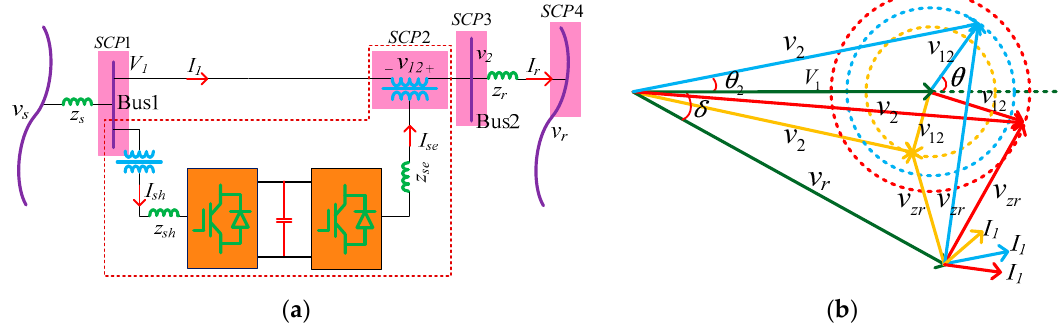
Figure 1. The structure and phasor diagrams of the unified power flow controller (UPFC): ( a ) Schematic diagram of the UPFC embedded system; ( b ) Phasor diagram of the UPFC embedded system.